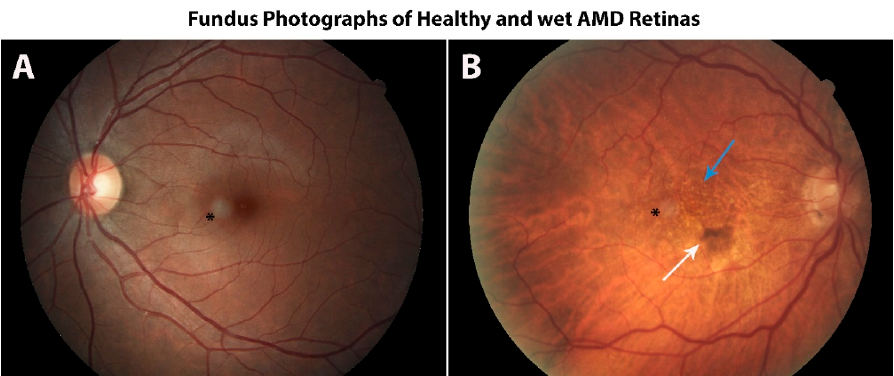
Figure 4. A healthy retina can undergo severe morphological changes due to wet age-related macular degeneration (AMD). Color photograph of a heavily pigmented fundus of a healthy volunteer ( A ) and the lightly pigmented fundus of a patient with wet AMD ( B ), which illustrates drusen (blue arrow) and retinal hemorrhage (white arrow). The black asterisk denotes a circular image artifact. (Images courtesy of Robert W. Snyder, MD, PhD).